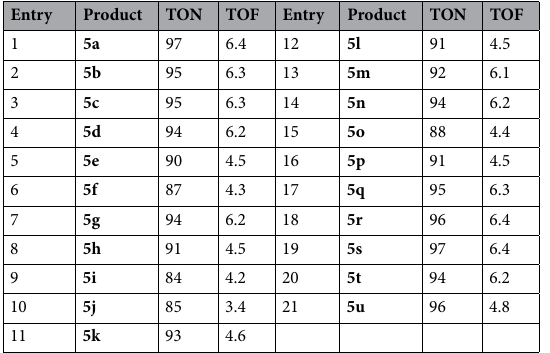
Table 4. In order to calculate the turnover number (TON) and turnover frequency (TOF), we made the following